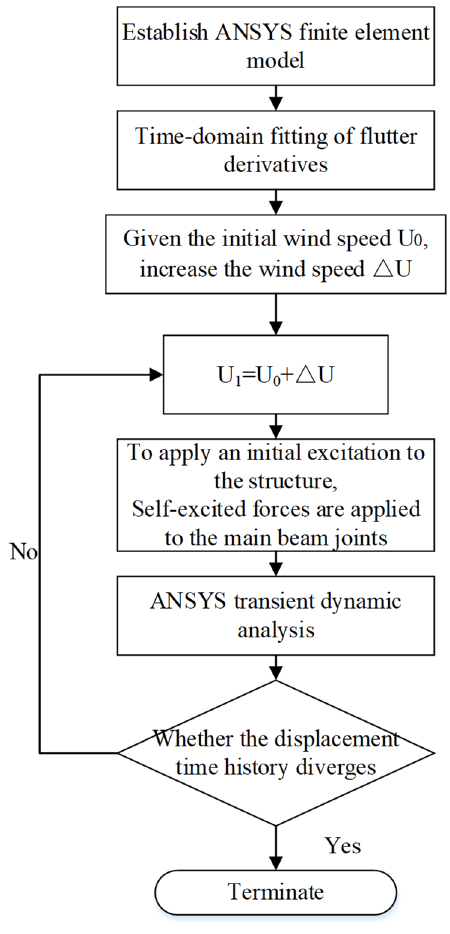
Figure 1. Flutter analysis process.